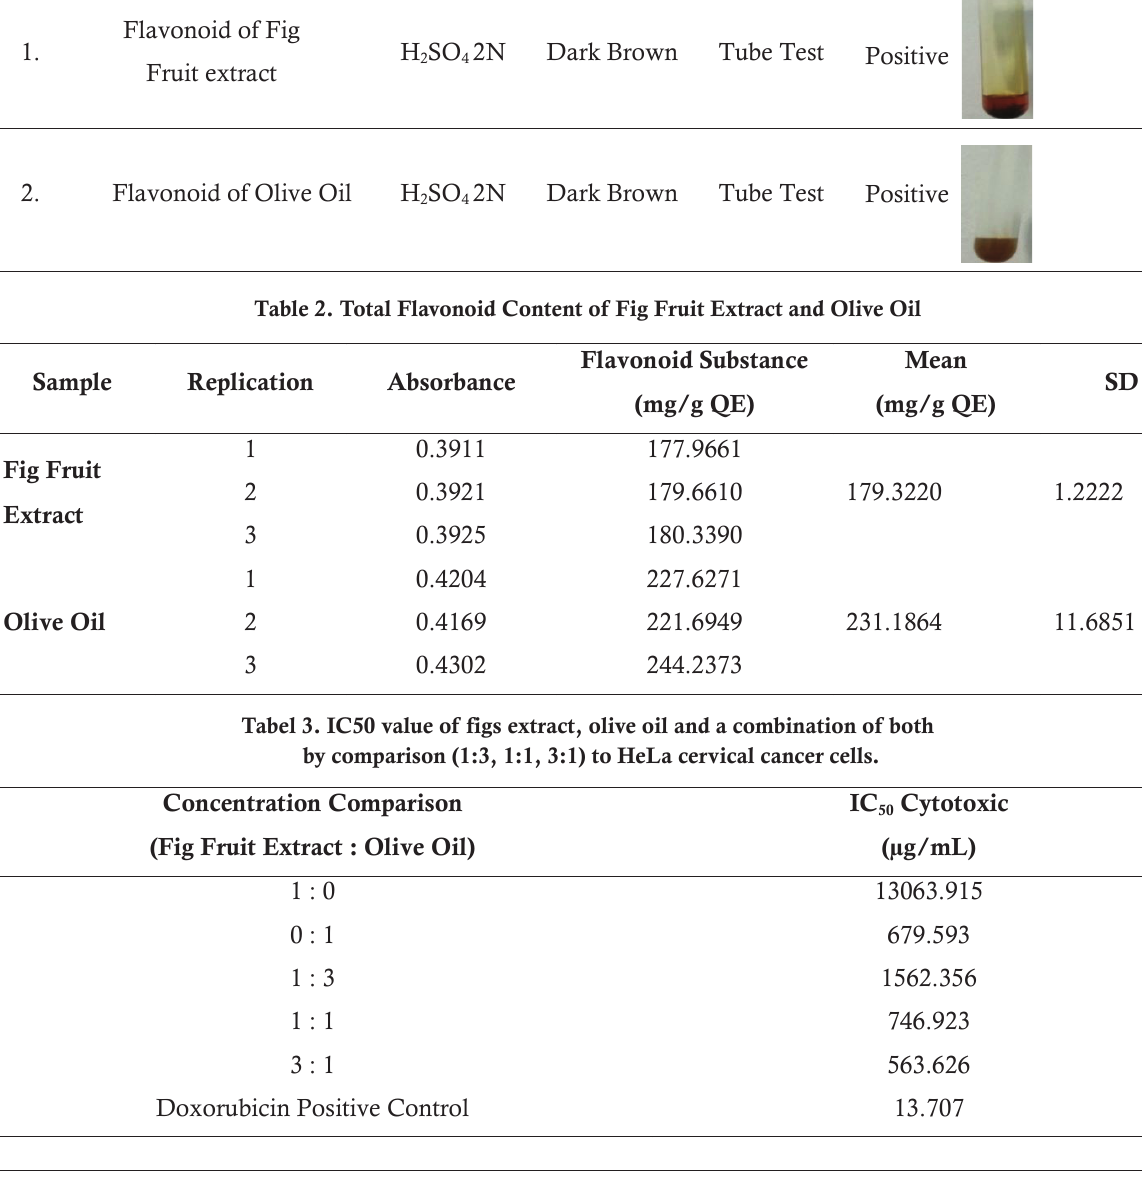
Table 1. Phytochemical Screening Test of Fig Fruit Extract ( Ficus carica L.) and Olive Oil ( Olea europeae L.) No Table 2. Total Flavonoid Content of Fig Fruit Extract and Olive Oil